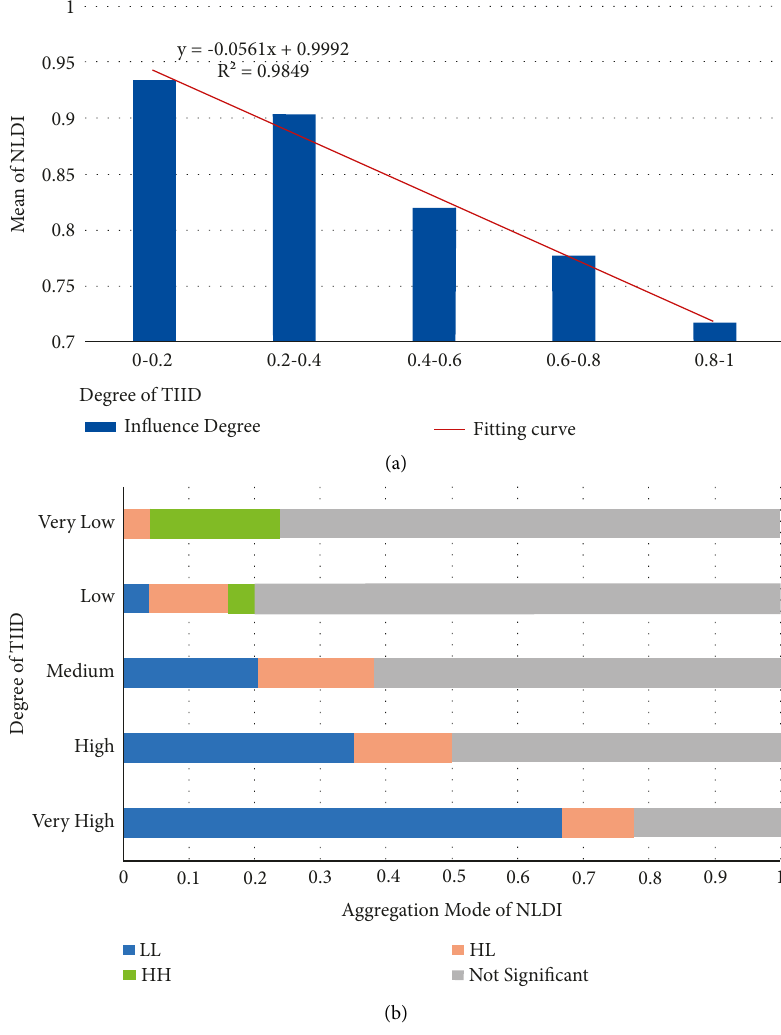
Figure 13: Statistics between NLDI and NLDI at the county